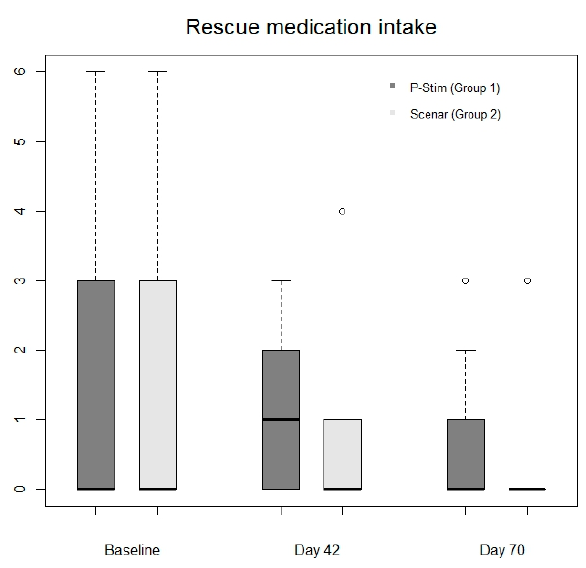
Figure 3. Comparison of required rescues medication.